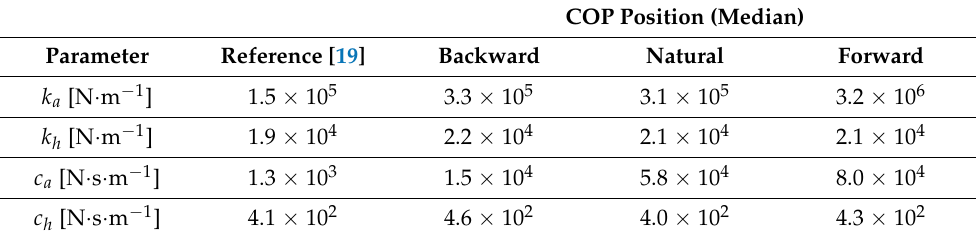
Table 3. Comparison between upper body parameters optimized in this study and those of previously published work